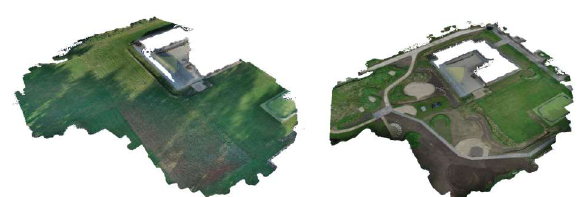
Figure 3: The mesh of epoch 1 (left) and the mesh of epoch 2 (right) in